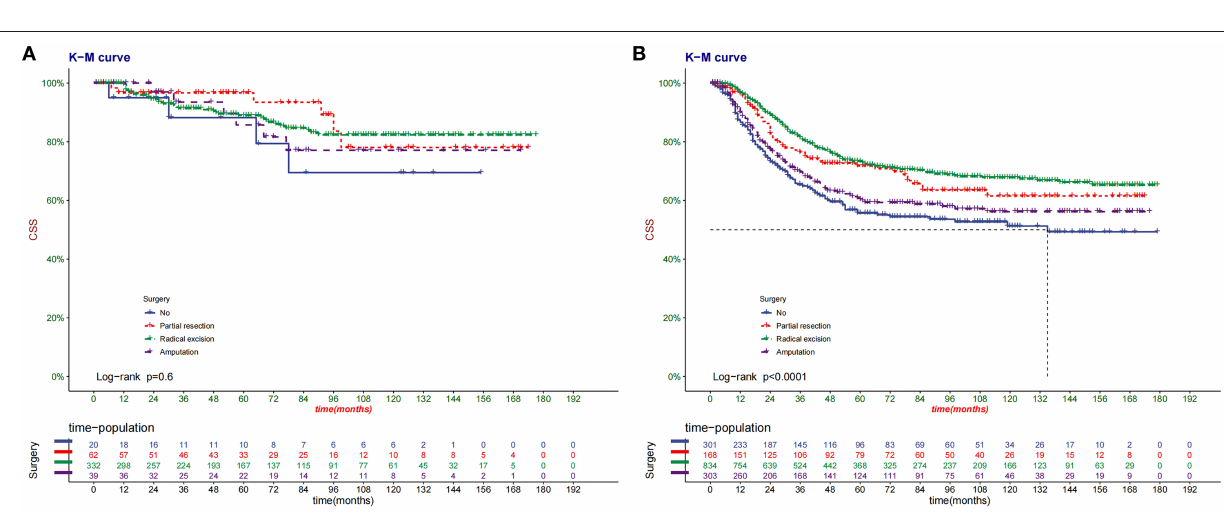
FIGURE 7 | Kaplan–Meier curves of CSS for children with different surgery in the low- (A) and high-risk (B) groups in total